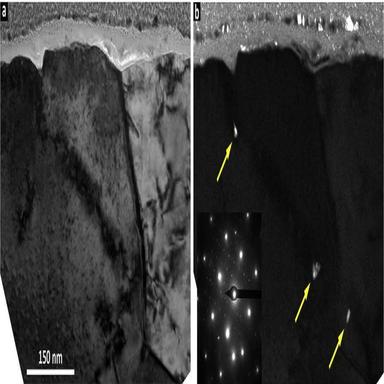
a) BF and b) corresponding CDF TEM images showing the migrated area at the GB of a sample tested in oxidizing conditions (R ¼ 1/24). The inset in b) is the selected area electron diffraction pattern that confirmed the presence of very fine M23C6 carbides that formed during the quench (arrowed).